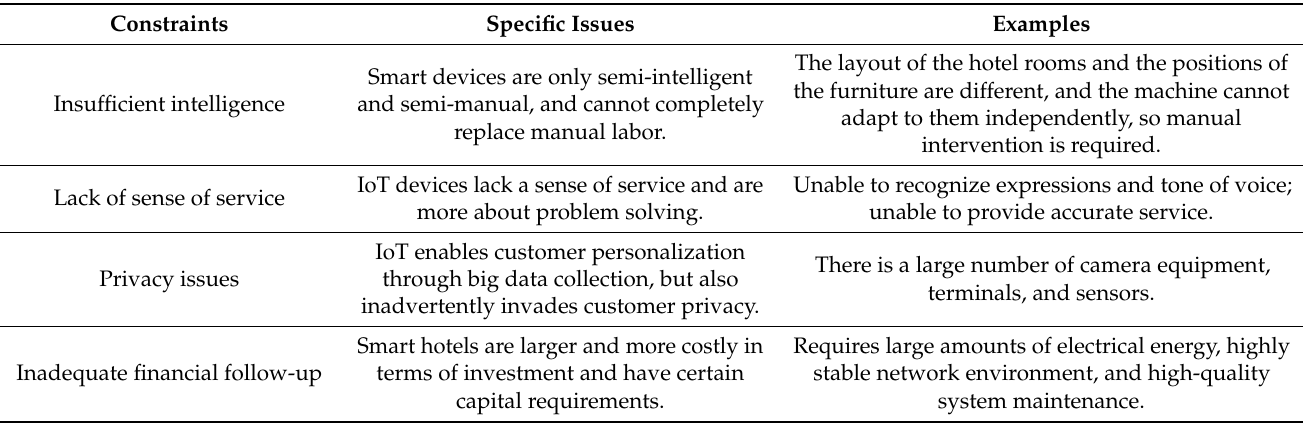
Table 3. The constraints of IoT application development in hospitality industry in China.